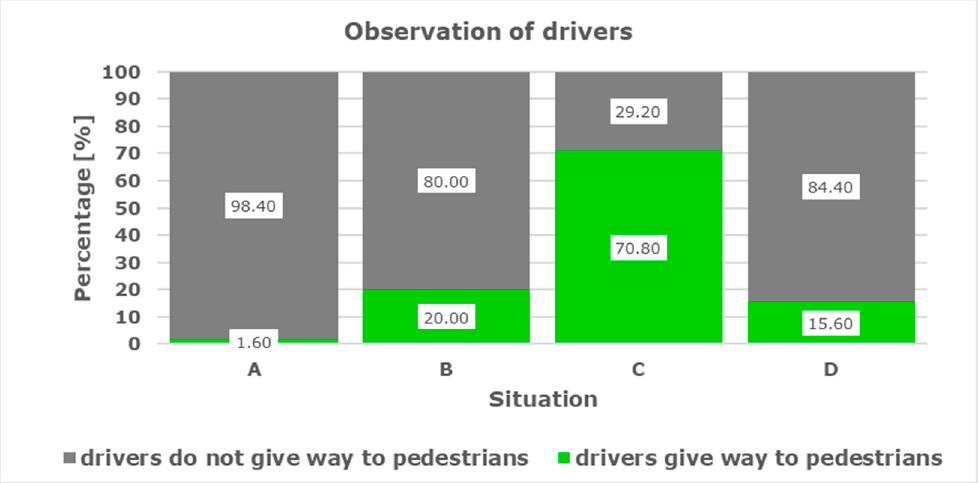
Figure 8. Results of observations of driver behaviour with regard to pedestrians in the crossing area. The results indicate that only 1.6% of drivers stopped in order to give way to pedes- trians approaching a crossing. The value of 20% of drivers giving way to pedestrians who were waiting to cross was not very large either, but it must be considered that, according to the regulations in place in Poland, the driver is not under an obligation to give way to pedestrians who are waiting to cross the roadway. Giving way to pedestrians in such situations is promoted as a positive way to behave in traffic. The result recorded in situation C is reason for serious concern: as many as 30% of drivers drive through a crossing, despite the fact that a pedestrian is already on the roadway. Such a behaviour of drivers leads to the negative statistics indicated in the first part of the